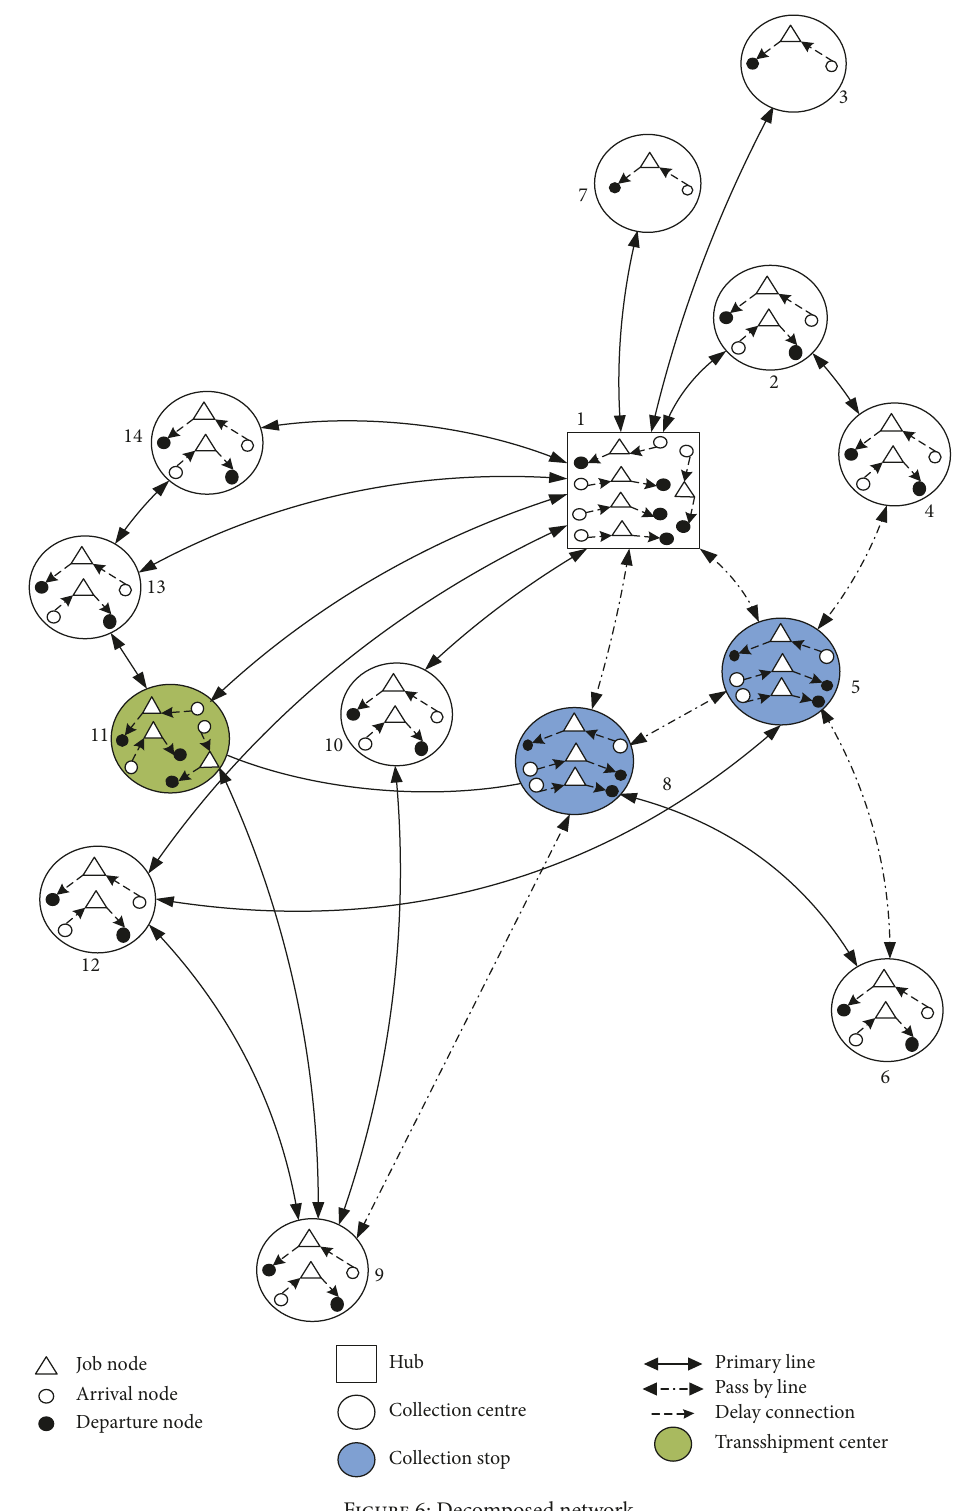
Figure 6: Decomposed